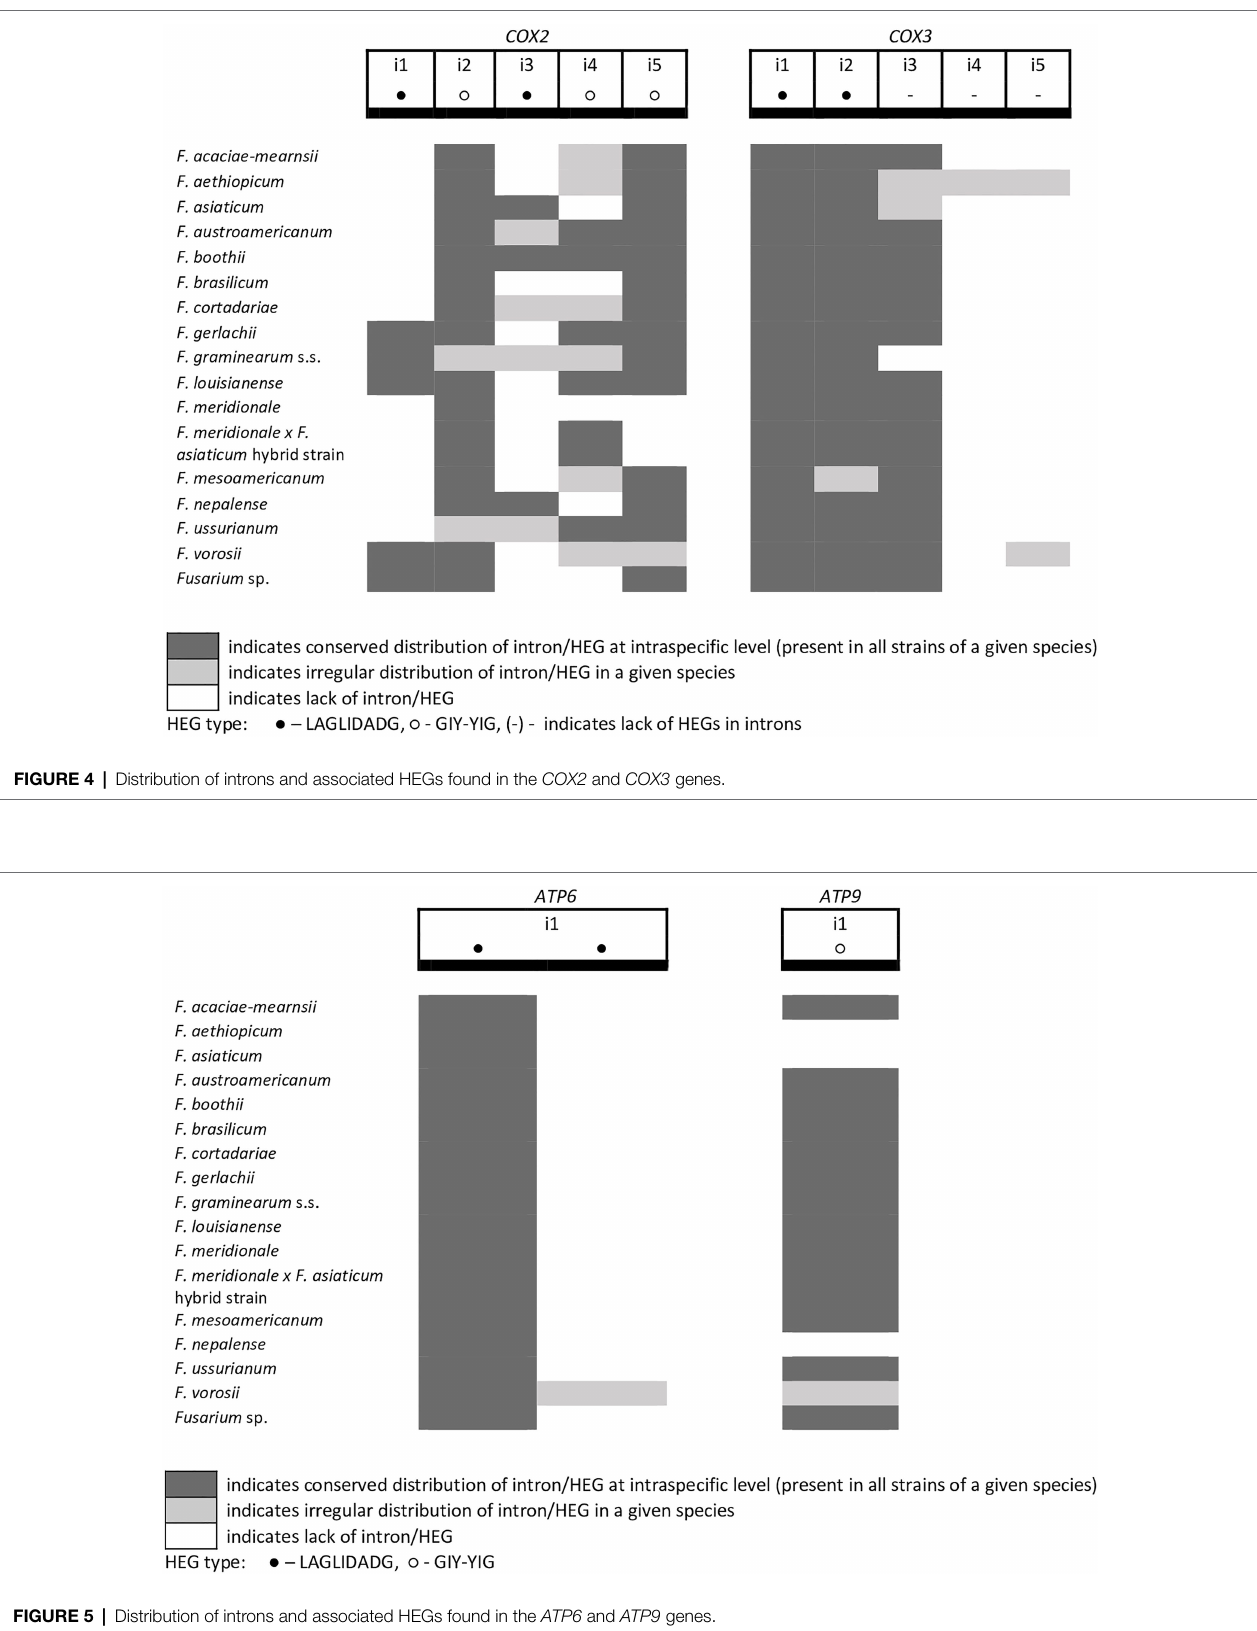
FIGURE 5 | Distribution of introns and associated HEGs found in the ATP6 and ATP9